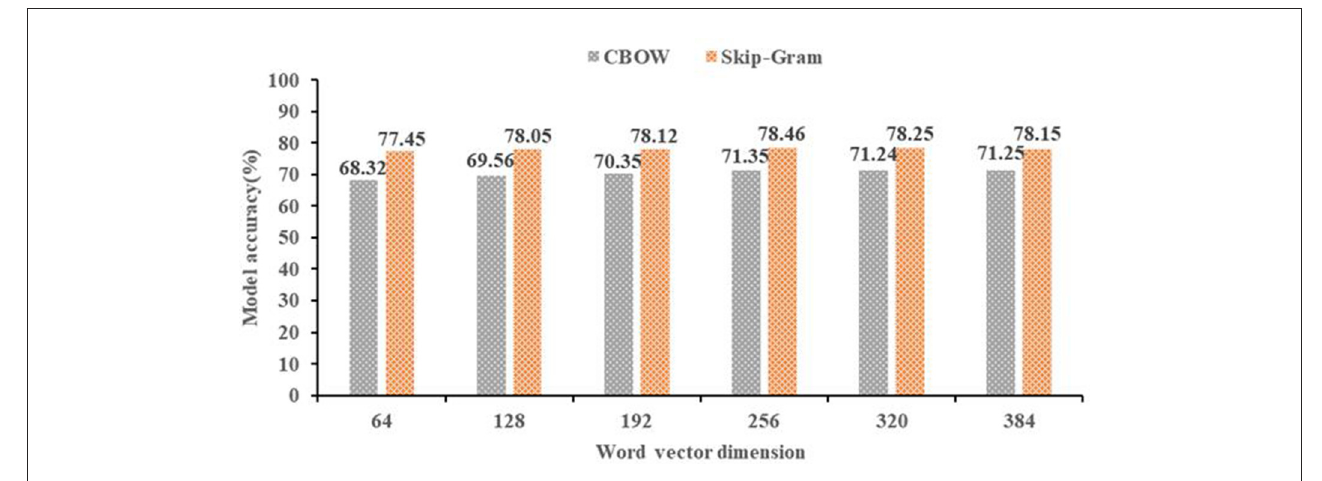
FIGURE4 Word vector